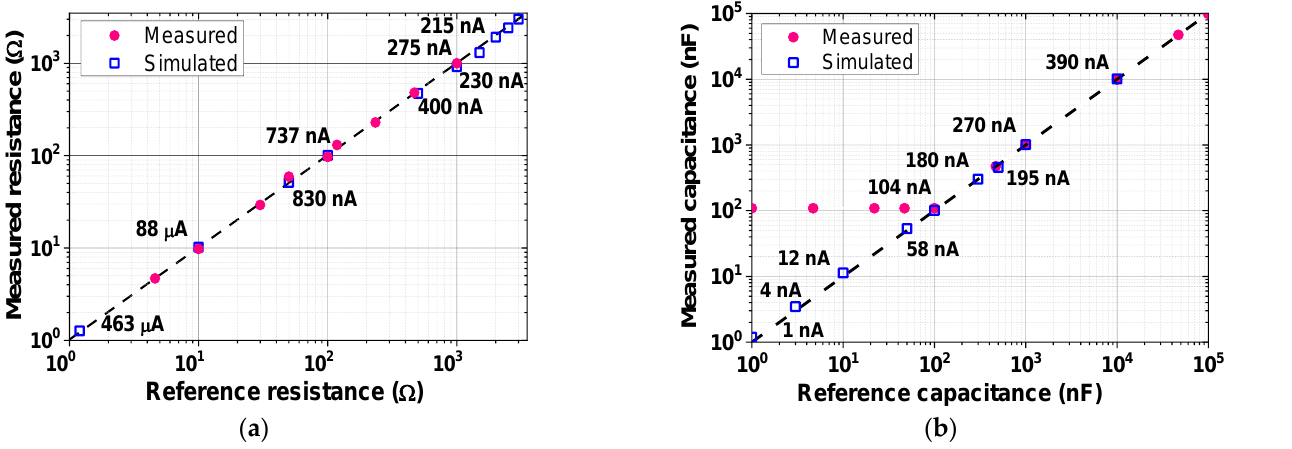
Figure 24. Measured result of the impedance channel. The current driver injects input at three fre- quencies (1 kHz, 4 kHz, and 5 kHz). The demodulation is performed at 5 kHz.